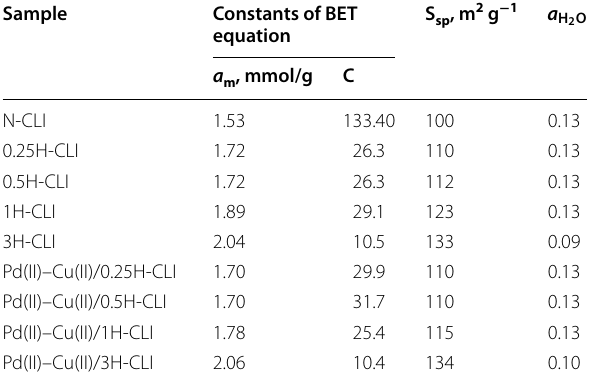
Table 4 Structural-adsorption parameters of natural and modified clinoptilolite samples